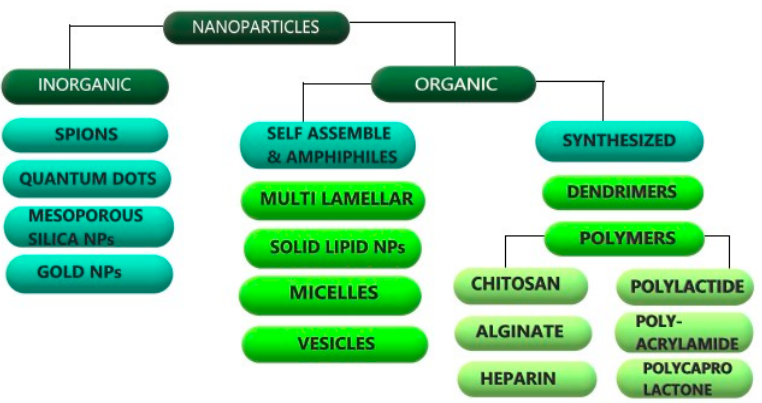
Figure 1. Classification of NPs.